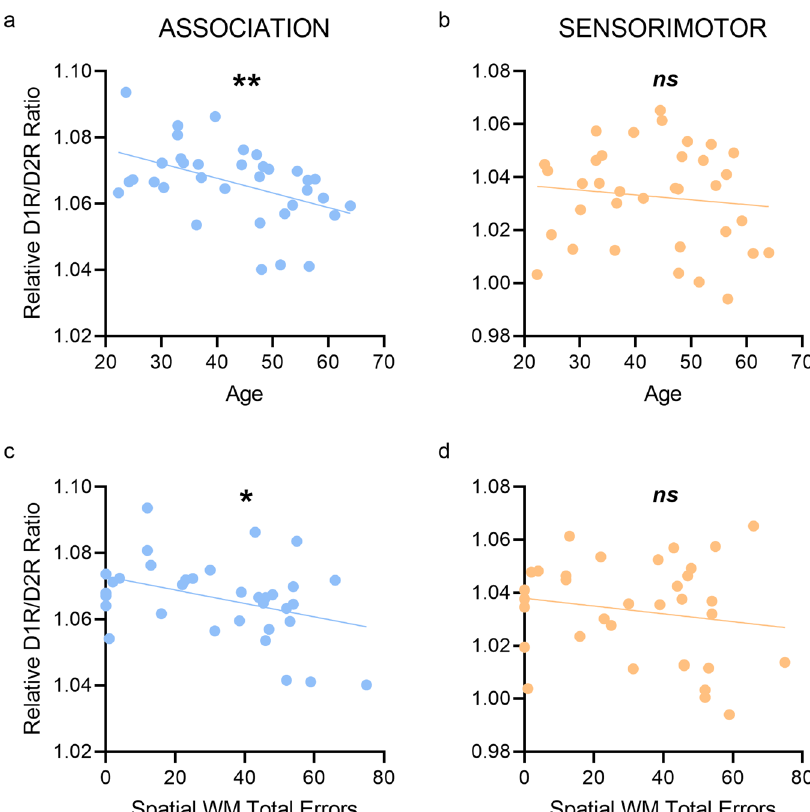
Fig. 4 Associations of relative D1R/D2R ratio with age and spatial working memory performance. Correlations between relative D1R/D2R ratio and age ( a , b ) and cognitive performance ( c , d ). Trend lines re fl ect the regression line of best fi t. WM working memory. ** p < 0.01; * p < 0.05; ns not signi fi cant ( p >